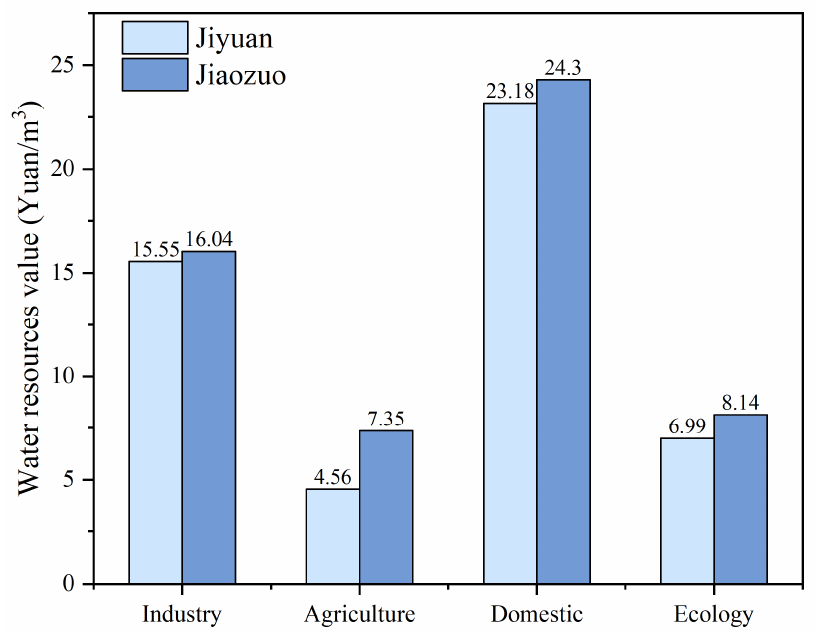
Figure 4. Water resources value of Jiyuan and Jiaozuo.